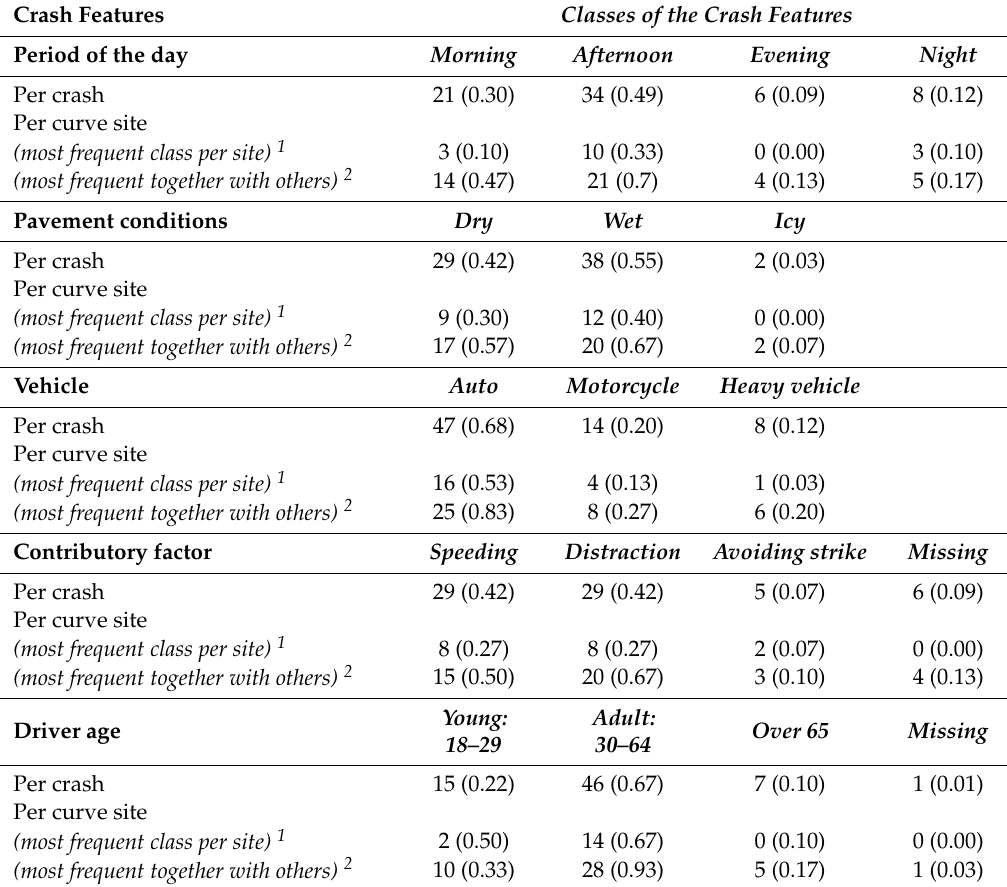
Table 1. Run-O ff -Road Fatal + Injury specific crash features at the selected two-way two-lane rural road curves with statistics averaged over the total crashes (69) and total curve sites